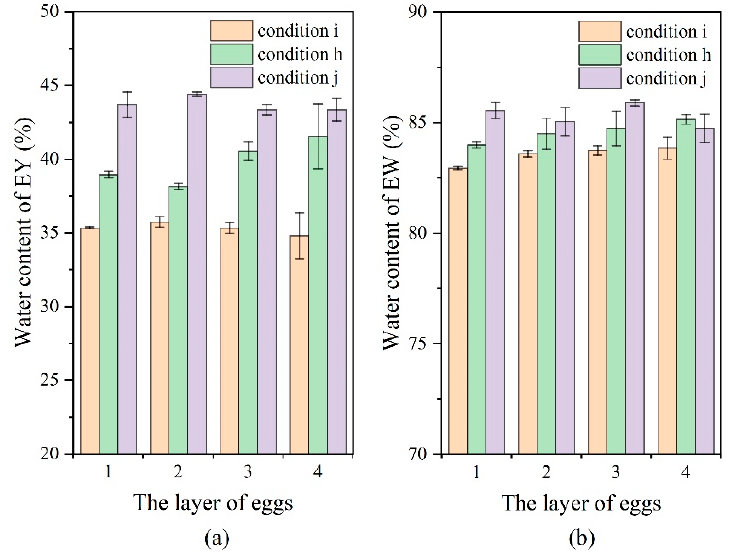
Figure 10. ( a ) EY water content in different layers under operating conditions h, i, and j; ( b ) EW water content in different layers under operating conditions h, i, and